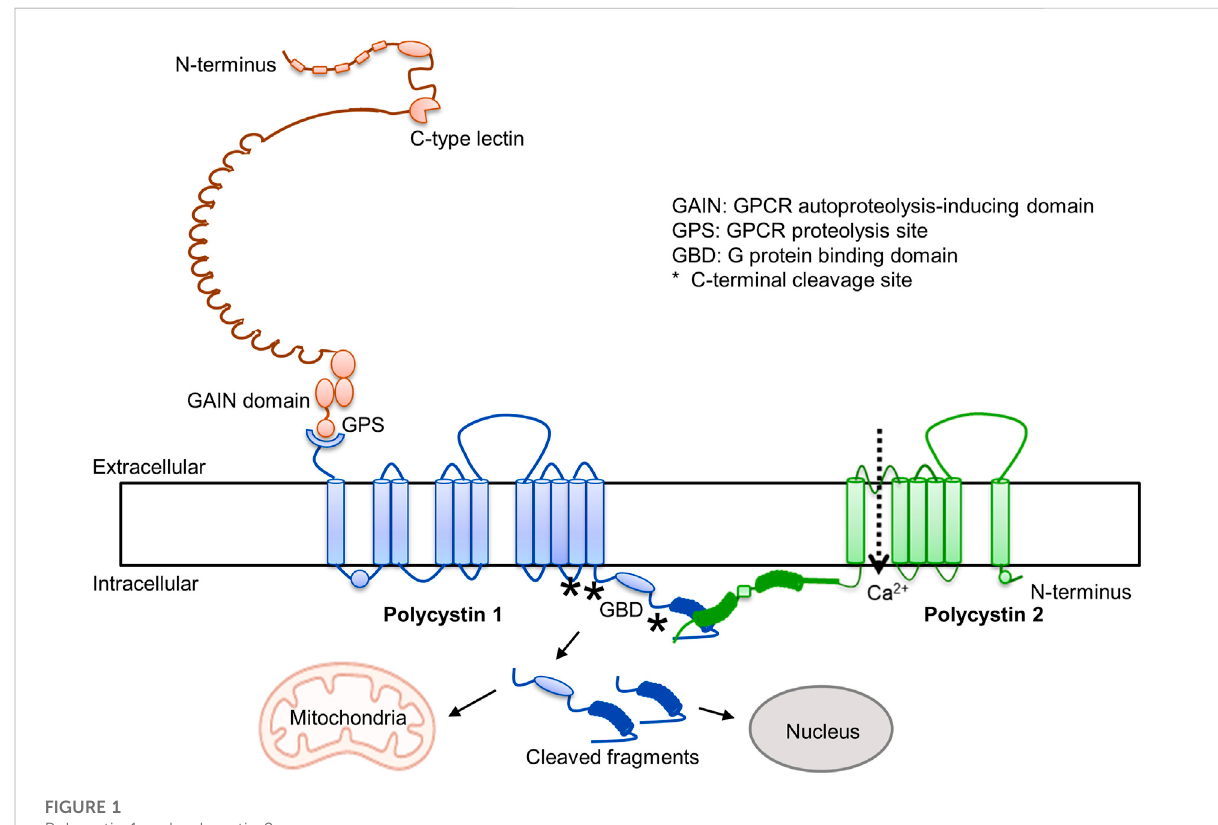
FIGURE 1 Polycystin 1 and polycystin